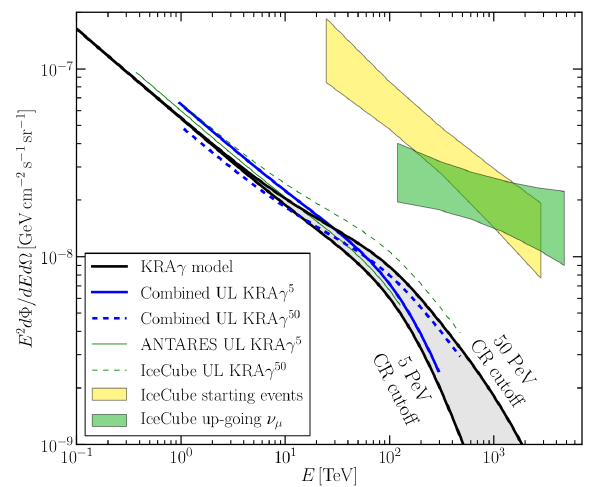
Figure 6. Combined ANTARES-IceCube upper limits [19] at 90% C.L. (blue) on the three- fl avor neutrino fl ux of the KRA γ model, for 5 and 50 PeV cuto ff .